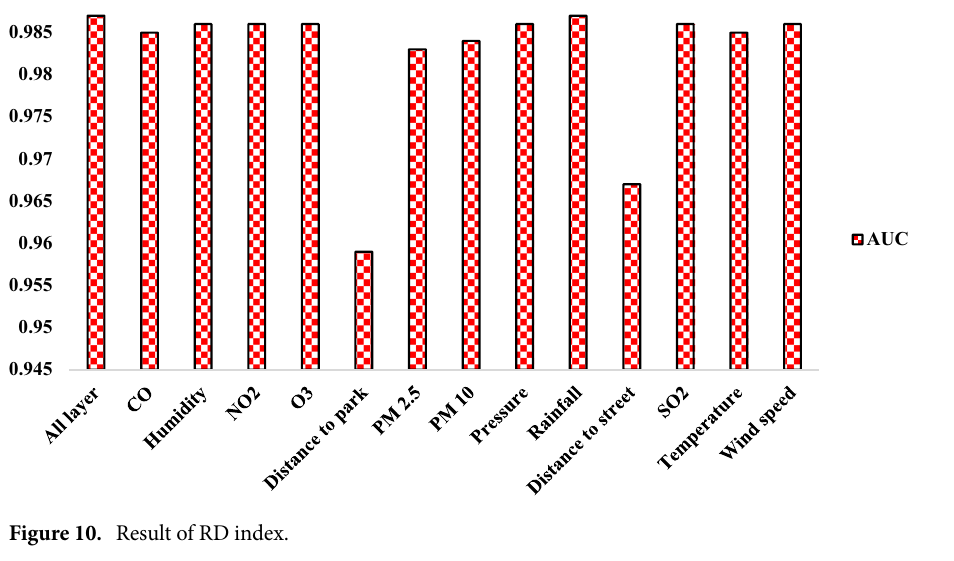
Figure 10. Result of RD